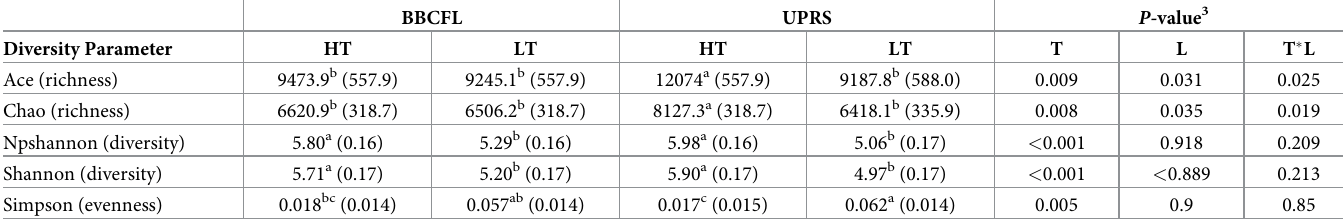
Table 2. Bacterial species richness and diversity estimators in fecal microbial communities across location 1 and tolerance groups 2 . BBCFL UPRS P -value